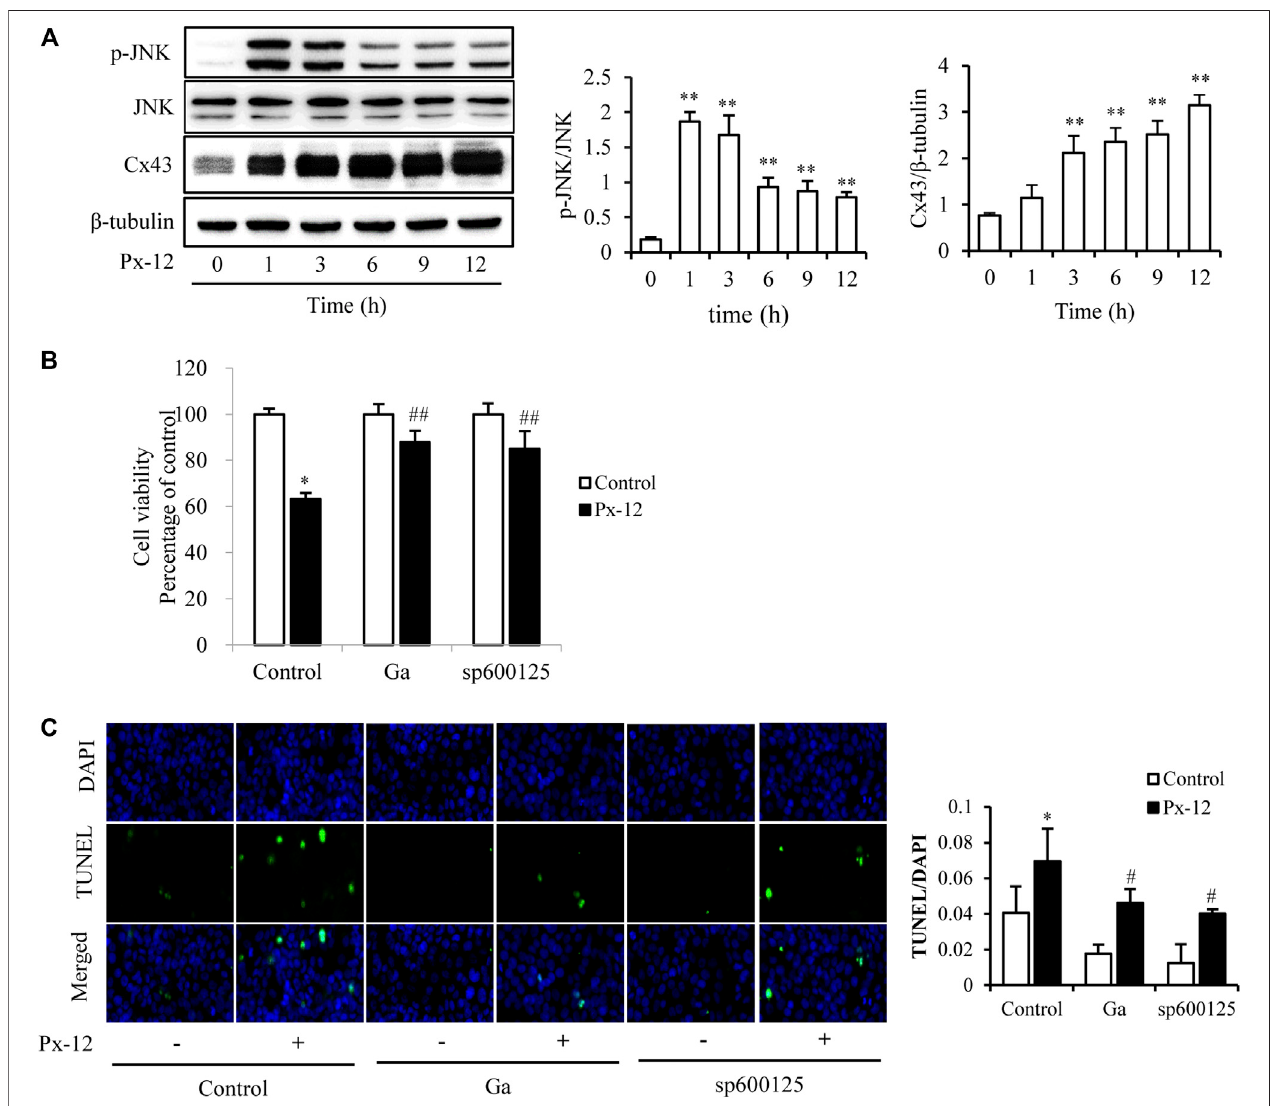
FIGURE3| c-JunN-terminalkinase(JNK)-mediatedoxidativestressinducesconnexin43(Cx43). (A) InductionofJNKphosphorylationandexpressionofCx43by Px-12. NRK-52E cells in 6-well plates were incubated with Px-12 for 0, 1, 3, 6, 9, and 12 h separately. Cellular lysates were then analyzed by western blotting for phosphorylatedJNKandCx43expression.Densitometricanalysisof p -JNKandCx43areshownontheright(mean ± SD, n (cid:2) 3;** p < 0.01vs.thecontrol,## p < 0.01vs. Px-12incontrol). (B) Effectsof18 α -glycyrrhetinicacid(Ga)andsp600125,aninhibitorofJNK,onPx12-inducedcellinjury.NRK-52E cellswerepretreatedwithGa (20 μ M)andsp600125(20 μ M)for1 handthenchallengedwithPx-12foranother24 h.Then,cellviabilitywasevaluatedusingaCellCountingKit-8(CCK-8)assay.Data are expressed as the percentage of living cells vs. the untreated control (mean ± SD, n (cid:2) 6). * p < 0.01 vs. the control. ## p < 0.01 vs. Px-12 in control. (C) In fl uence of sp600125 and Ga on NRK-52E cell apoptosis staining. NRK-52E cells in 96-well plate were pretreated with 18 α -Ga and sp600125 for 1 h and then incubated with Px- 12foranother24 h.Then,apoptoticcellswerestainedviaDT-mediateddUTPnickendlabeling(TUNEL)and4,6-diamidino-2-phenylindole(DAPI)(magni fi cation, × 400). The ratio of positive cells is shown on the right (mean ± SD, n (cid:2) 3; ** p < 0.01 vs. the control, ## p < 0.01 vs. Px-12 in the control).